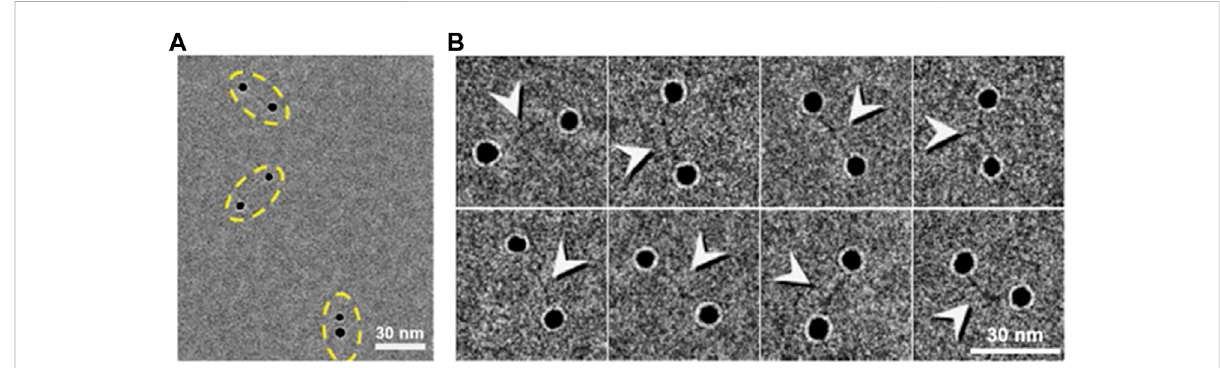
FIGURE 7 Cryo-EM images of dsDNA-nanogold conjugates. (A) Cryo-EM images of 5-nm nanogold particles conjugated to 84-bp dsDNA via a 50-thiol linkerwith thinvitreousice.Pairsofnanogoldweremarkedbyyellowdashedovals. (B) Eightrepresentativecryo-EM images oftheparticlesofDNA- nanogold conjugates. Polygonal-shaped areas are the nanogold particles were bridged by a fi ber-shaped density (high-contrast densities were indicated by arrows), ~20 – 30 nm in length and ~2 nm in width. Reproduced with permission (Zhang et al., 2016).